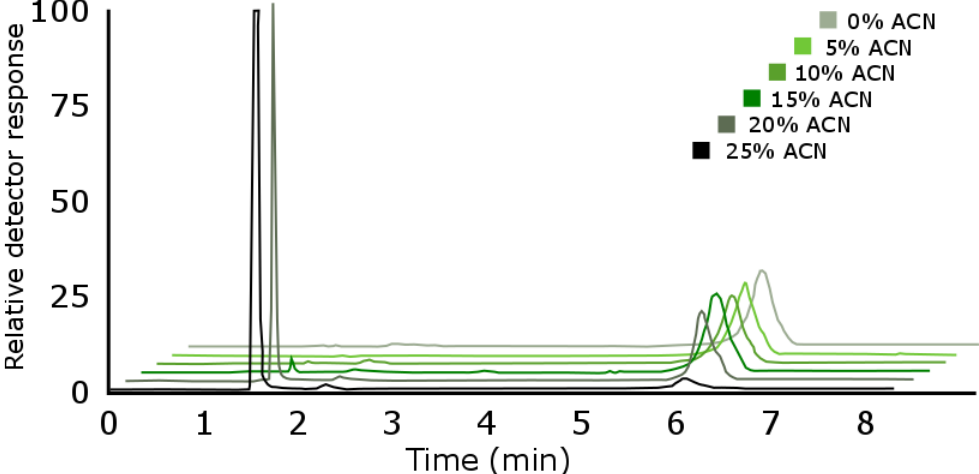
ff erent injection solvents.